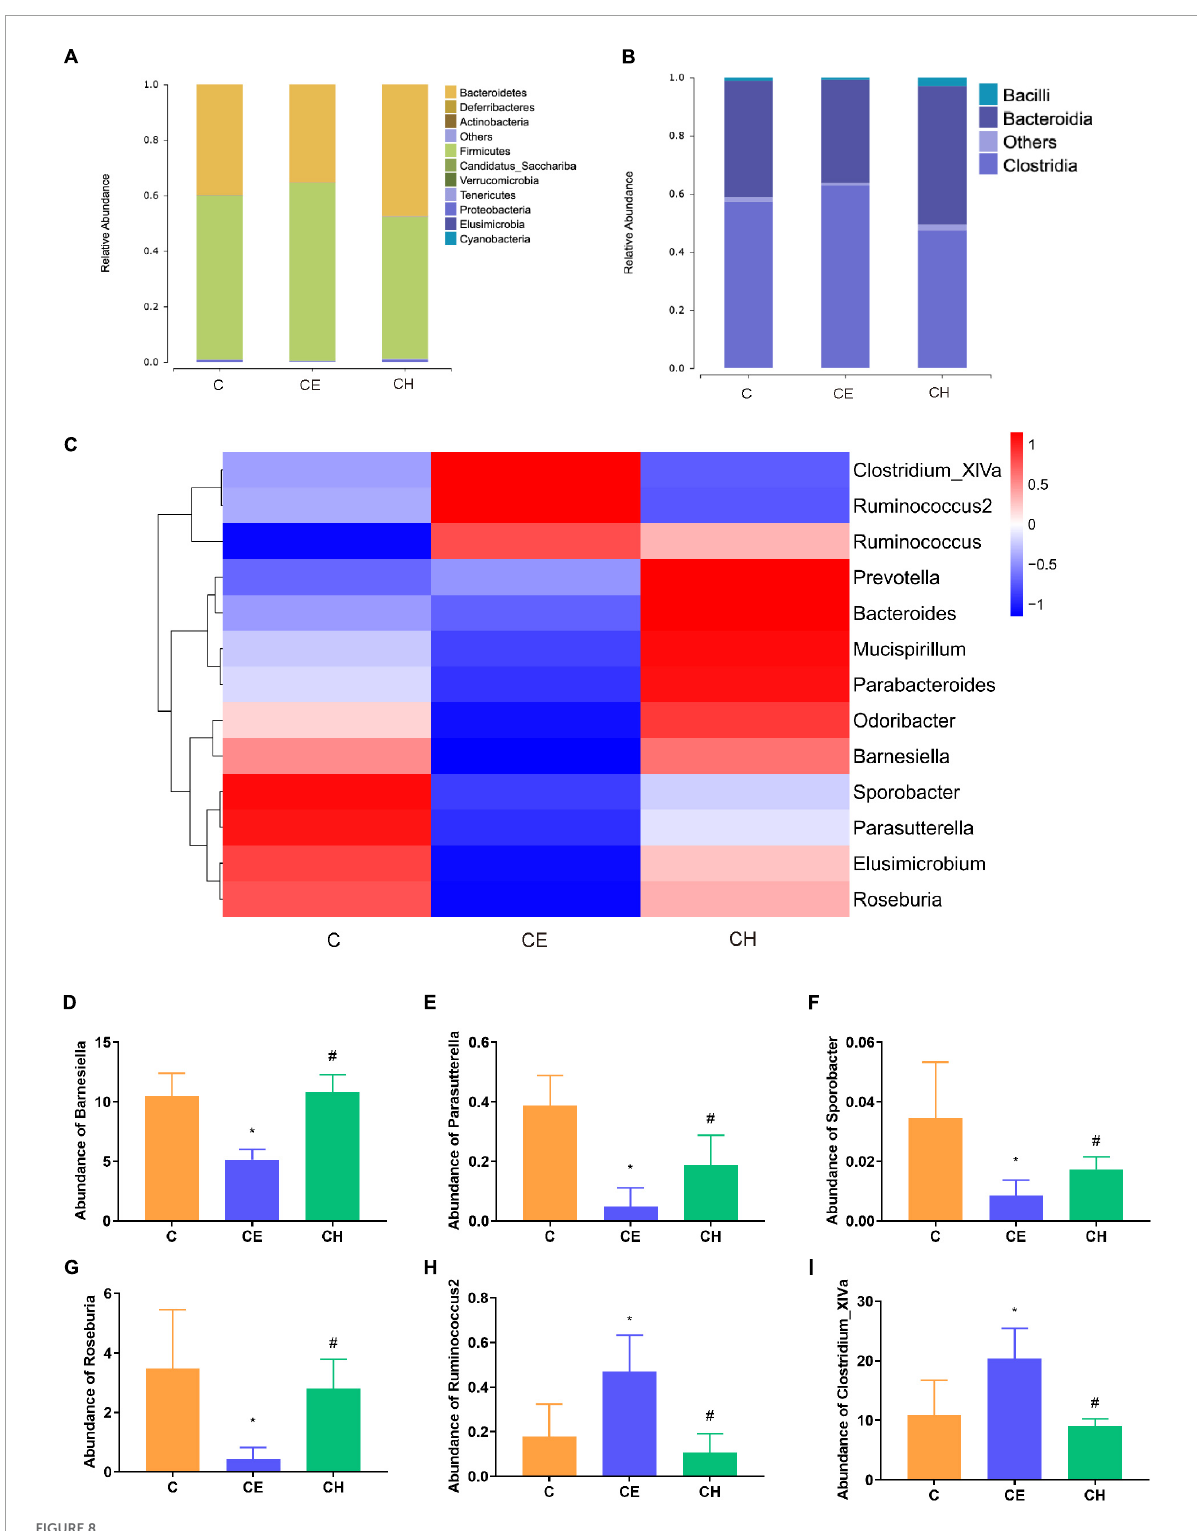
FIGURE8 Relative abundance levels of the gut microbial community. (A) Phylum level; (B) class level; (C) genus level ( n = 5); (D) abundance of Barnesiella ; (E) abundance of Parasutterella ; (F) abundance of Sporobacter ; (G) abundance of Roseburia ; (H) abundance of Ruminococcus2 ; (I) abundance of Clostridium_XlVa ; *Means are significantly different vs. C group (* p < 0.05); # Means are significantly different vs. CE group ( # p < 0.05); C, control group; CE, cold exposure group; CH, Chinese herbs complex